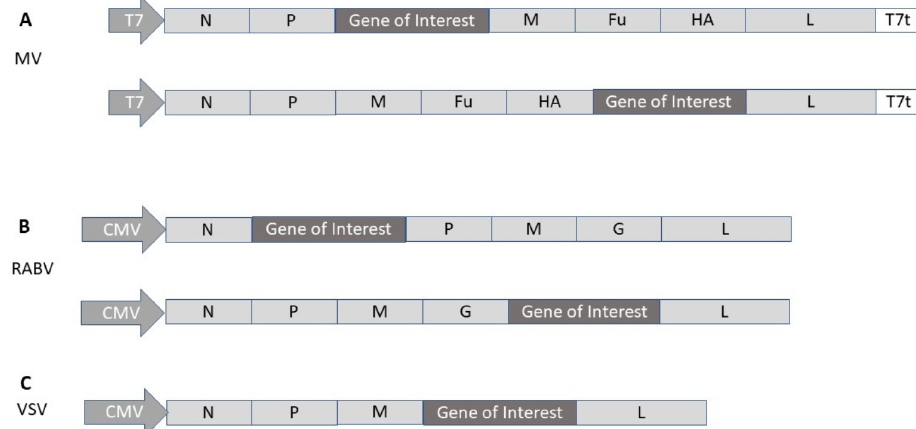
Figure 4. Measles virus (MV) and rhabdovirus expression vectors. ( A ) MV vector, where the gene of interest can be inserted either between the P and M genes or the HA and L genes. ( B ) Rabies virus (RABV) vector with the gene of interest inserted either between the N and P genes or the G and L genes. ( C ) Vesicular stomatitis virus (VSV) vector with the gene of interest inserted between the M and L genes. CMV, cytomegalovirus promoter; Fu, fusion protein; G, glycoprotein; HA, hemagglutinin; L, large; M, matrix; N, nucleocapsid protein; P, phosphoprotein; T7, T7 RNA polymerase promoter; T7t, T7